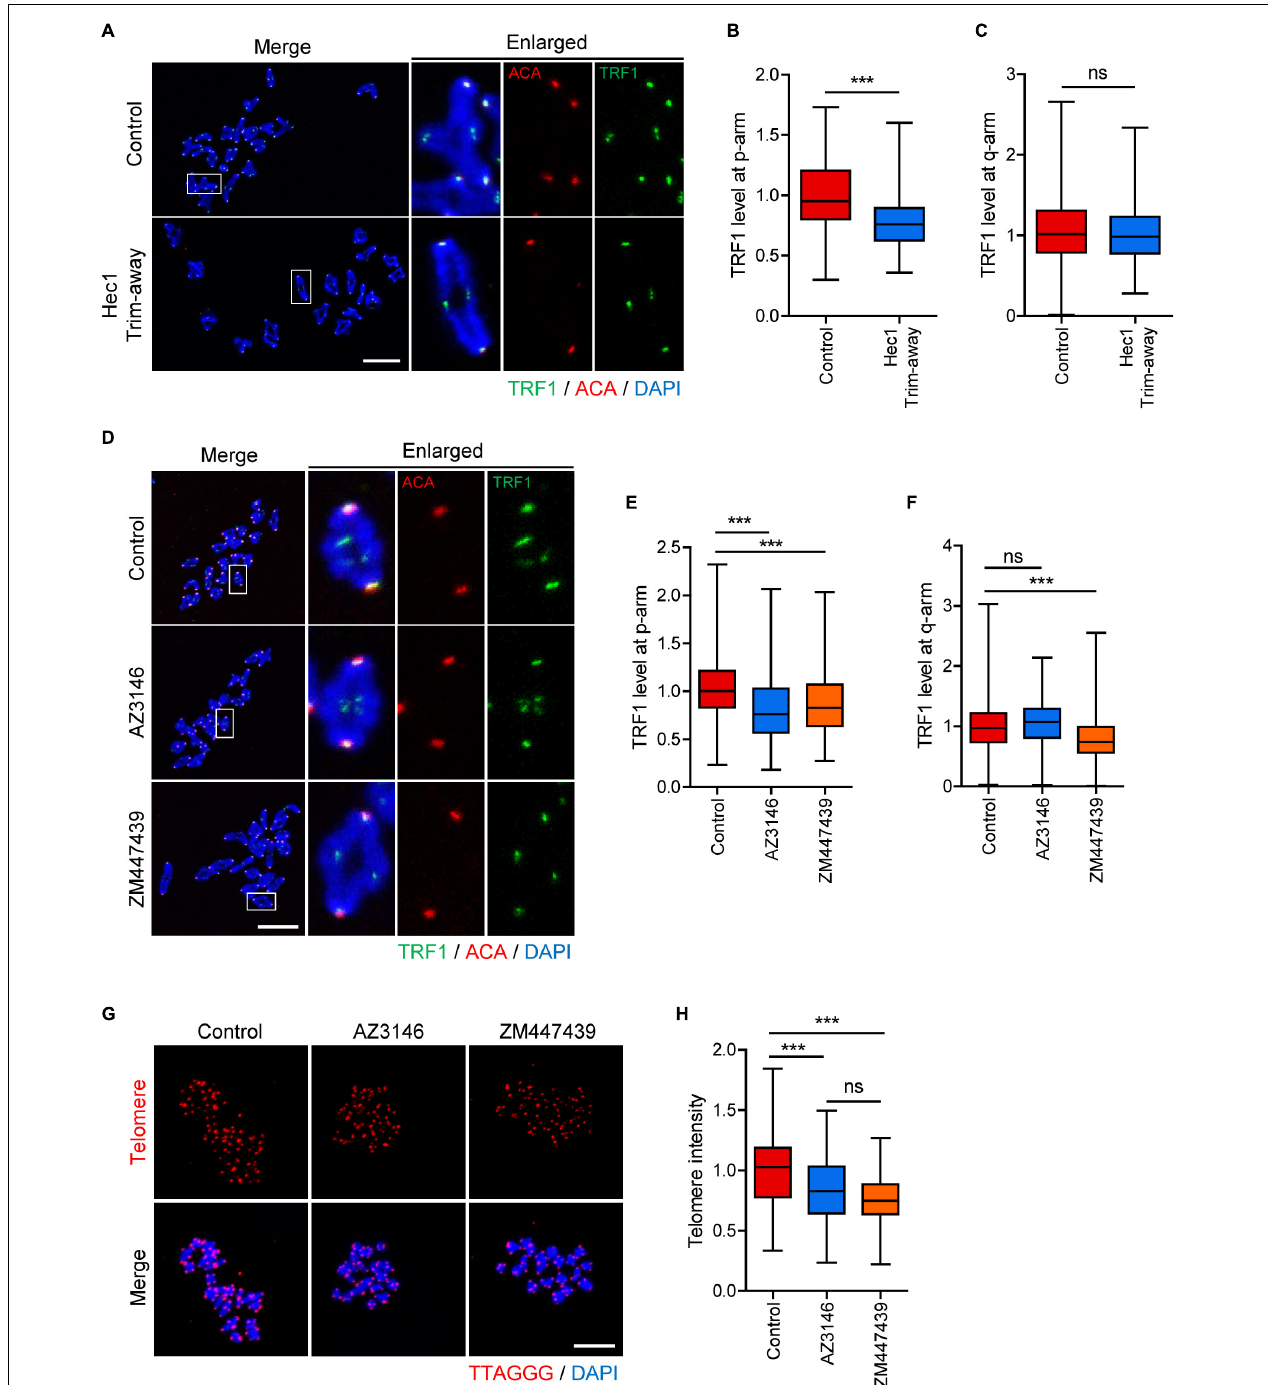
FIGURE 5 | Inhibition of inner centromere or kinetochore function decreases TRF1 level at telomeres. (A–C) Ndc80/Hec1 chromosome spreads were prepared from MI oocytes depleted Hec1 using the Trim-away method, and chromosome spreads were stained with anti-TRF1 antibody. Kinetochores and DNA were labeled with anti-centromere antibody (ACA) and DAPI, respectively (scale bar, 20 µ m). (A) Representative images from three independent experiments are shown. (B,C) The normalized intensity of TRF1 at p-arms and q-arms was quantified. (D–F) Chromosome spreads were prepared from MI oocytes after treatment with DMSO (Control), AZ3146, or ZM447439 and stained with anti-TRF1 antibody. Kinetochores and DNA were labeled with anti-centromere antibody (ACA) and DAPI, respectively (scale bar, 20 µ m). (D) Representative images from three independent experiments are shown. (E,F) The normalized intensity of TRF1 at p-arms and q-arms was quantified. (G,H) After treating with DMSO (Control), AZ3146, or ZM447439, oocytes were cultured for 12 h and subjected to telomere Q-FISH. Relative telomere FISH intensity was quantified and shown with representative images (scale bar, 20 µ m). ns; not significant, *** p < 0.001.